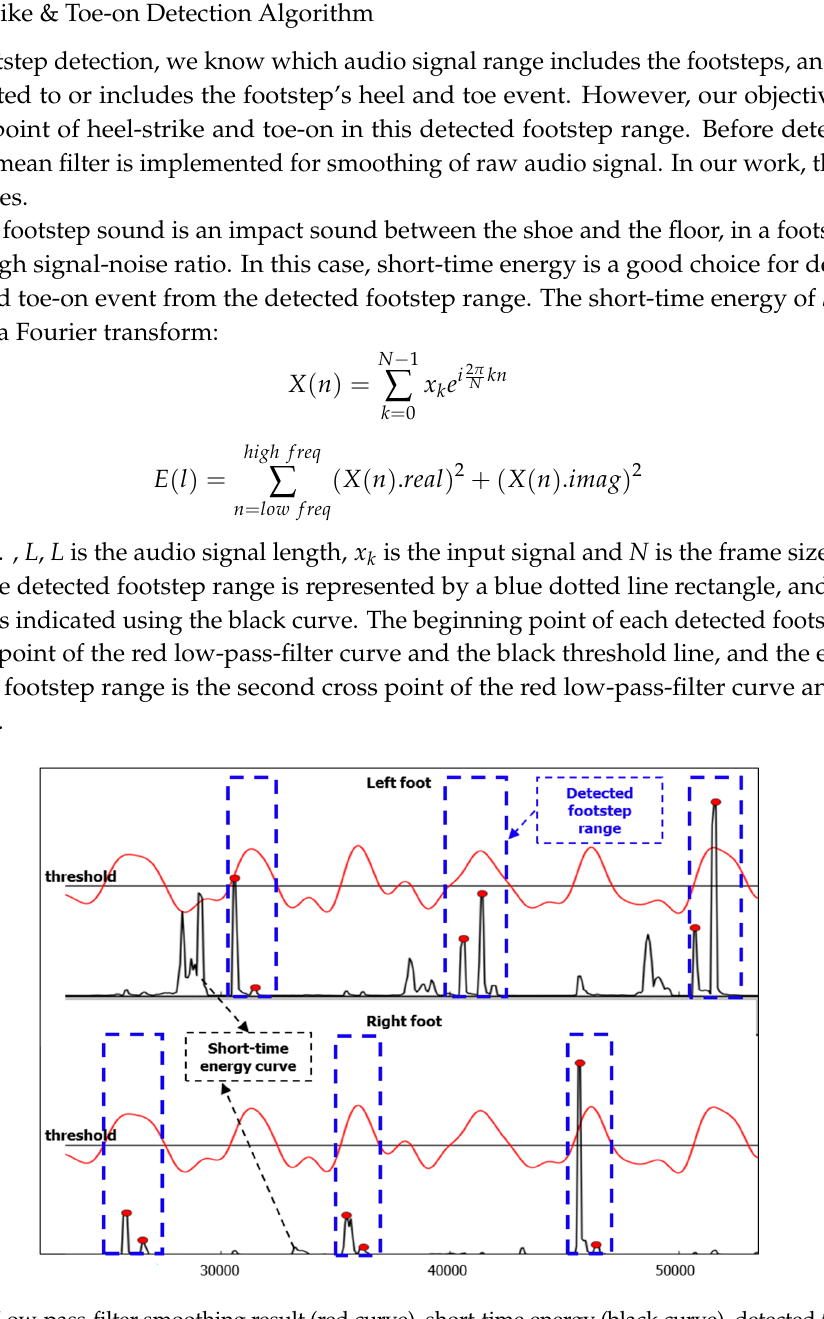
Figure 6. Low-pass-filter smoothing result (red curve), short-time energy (black curve), detected footstep (blue dotted line rectangle), detected events of heel-strike and toe-on (red circular dots).